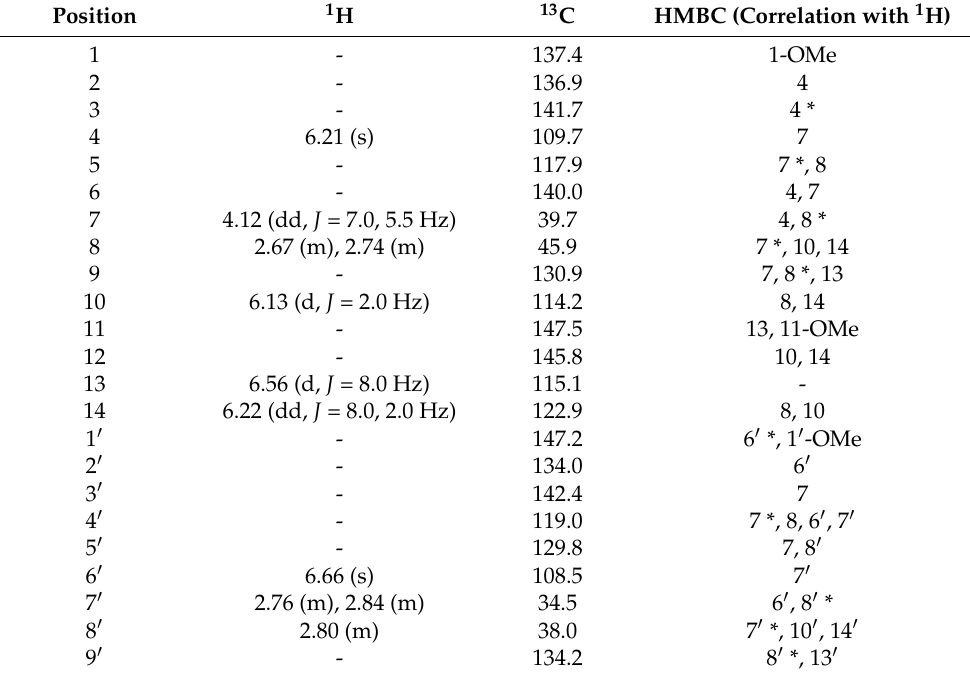
Table 1. 1 H (500 MHz) and 13 C NMR (125 MHz) spectral data of compound 1 in acetone- d 6 . Position 1